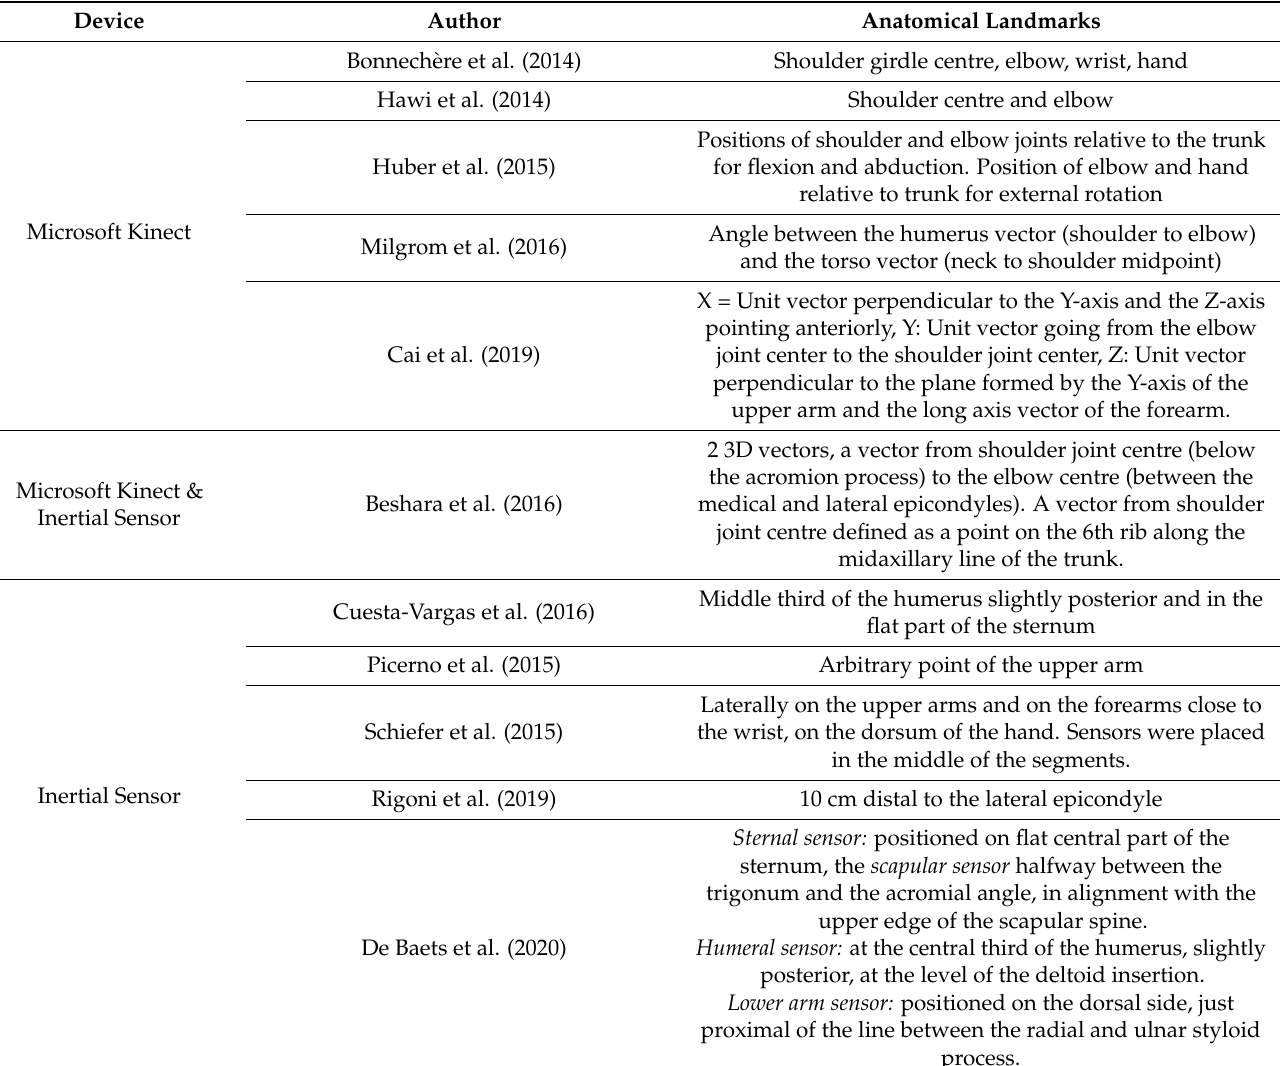
Table 5. Anatomical landmarks by